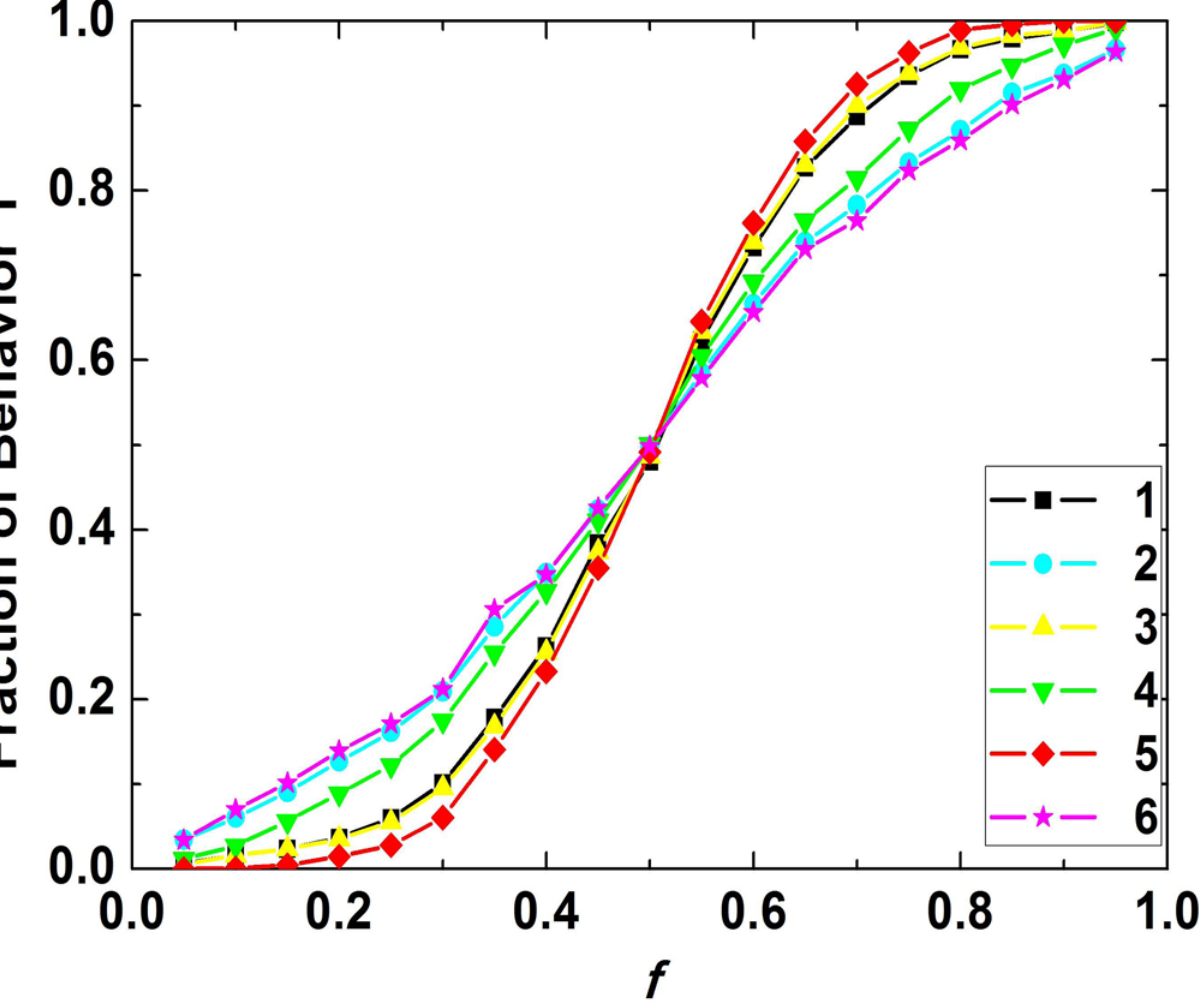
Fig 3. Relationship between the fraction of behavior 1 in population and the fraction of small group 1. The curves in the figure are with the same q (equal to 1), but the game parameters are not the same. For parameter group 1, [ B 1 , B 2 , B 3 , B 4 , C 1 , C 2 , C 3 , C 4 ] = [2, 2, – 1, – 1, 1, 1, 2, 2]. For parameter group 2, [ B 1 , B 2 , B 3 , B 4 , C 1 , C 2 , C 3 , C 4 ] = [1, 1, – 1, – 1, 1, 1, 2, 2]. For parameter group 3, [ B 1 , B 2 , B 3 , B 4 , C 1 , C 2 , C 3 , C 4 ] = [2, 2, – 2, – 2, 1, 1, 2, 2]. For parameter group 4, [ B 1 , B 2 , B 3 , B 4 , C 1 , C 2 , C 3 , C 4 ] = [1, 1, – 2, – 2, 1, 1, 2, 2]. For parameter group 5, [ B 1 , B 2 , B 3 , B 4 , C 1 , C 2 , C 3 , C 4 ] = [2, 2, – 1, – 1, 2, 2, 2, 2]. For parameter group 6, [